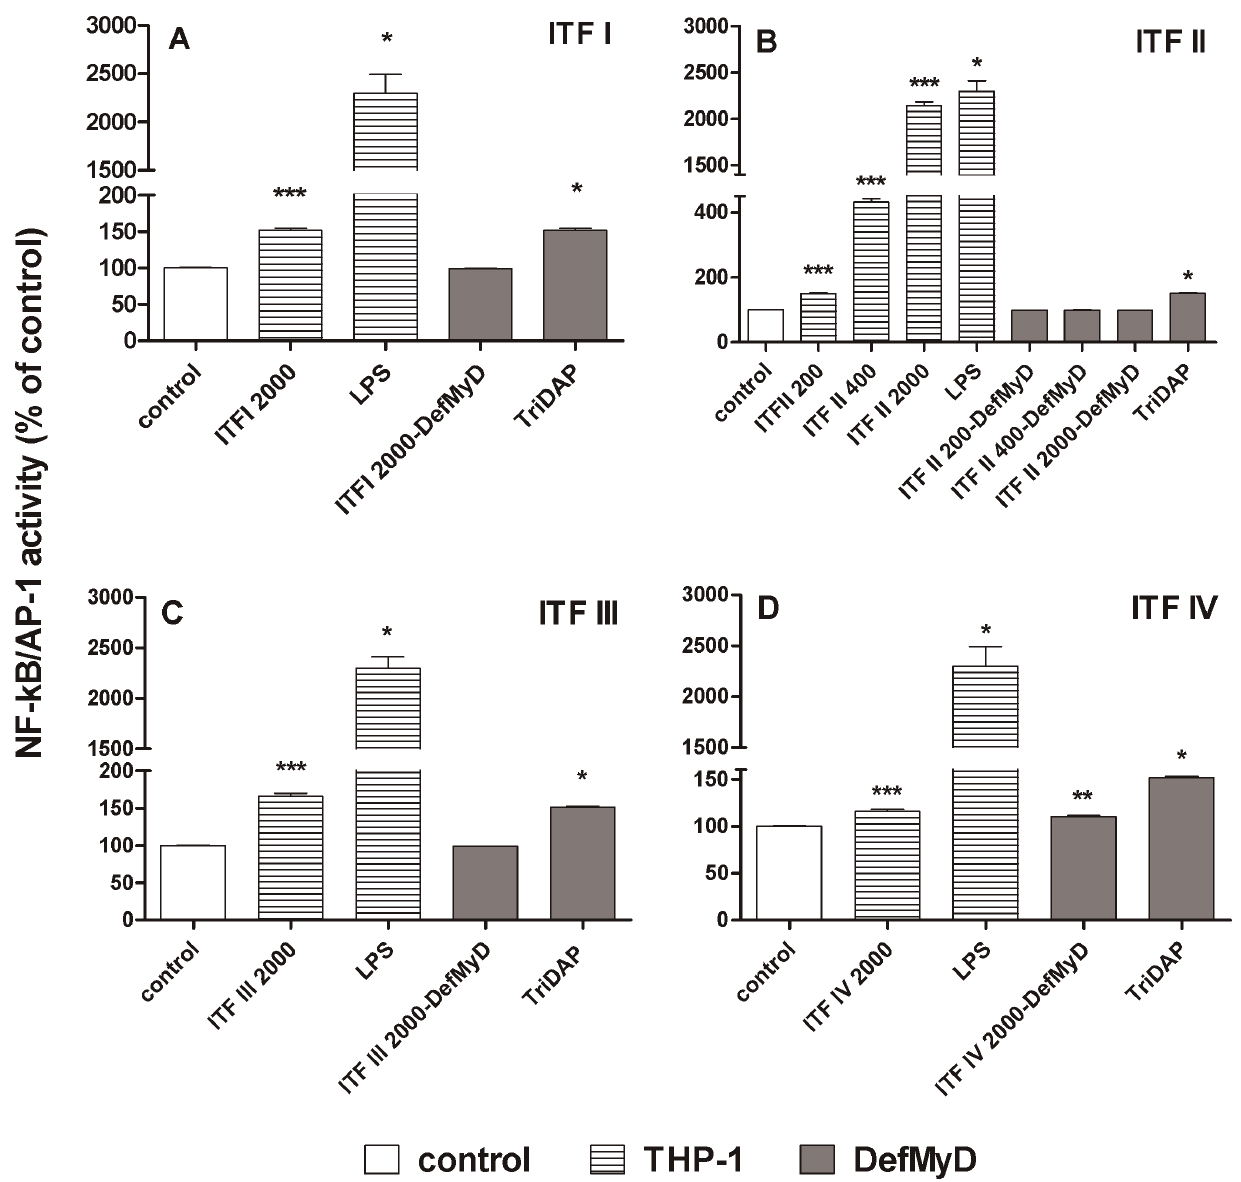
Figure 5. NF- k B/AP-1 activation in THP-1 MD2-CD14 and THP-1 defMyD reporter cells. Statistical significance levels were determined with a non-parametric Mann-Whitney U-test for unpaired observations (two-tailed). Mean and SD of NF- k B/AP-1 activation by b 2 R 1-fructans of different chain lengths (ITF I, II, III and IV) are plotted as percentage of negative controls (unstimulated cells), which were set to 100% for both cell lines. LPS stimulation was used as a common positive control for TLR4/MyD88 signalling to NF- k B/AP-1 in the functional THP-1 MD2-CD14 cell line. TriDAP was used as a positive control in THP-1 DefMyD cells, which induces MyD88-independent signalling to NF- k B/AP-1. Panel A to D represent cytokine expression induced by ITF I to IV respectively. Only concentrations which induced activation in the THP-1 MD1-CD14 cells are shown for comparison of these concentrations in the THP-1 DefMyD cells.